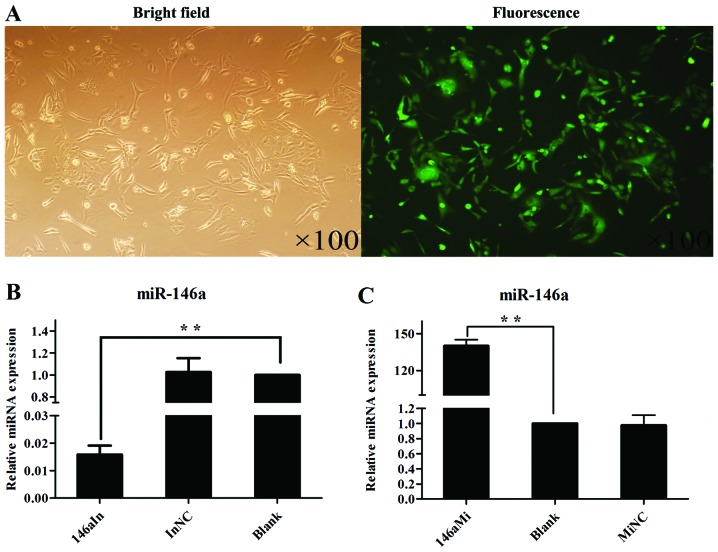
mMiR-146a oligonucleotide transfection and miR-146a expression in human chondrocytes. (B and C) Human chondrocytes were transfected with miR-146a mimics (146aMi), negative control mimics (MiNC), miR-146a inhibitors (146aIn), negative control inhibitors (InNC) and vacuous oligonucleotide (Blank). (A) Human chondrocytes were observed with white bright (left panel) and green fluorescence assay (right panel) in the same vision using a fluorescence microscope (magnification, ×100) at 24 h after transfection. (B) miR-146a expression levels were evaluated by RT-qPCR in the chondrocytes transfected with miR-146a inhibitors (146aIn) and negative control inhibitors (InNC) (**P<0.01; bars, means ± SD; n=3). (C) miR-146a expression levels were evaluated by RT-qPCR analysis in chondrocytes transfected with miR-146a mimics (146aMi) and negative control mimics (MiNC) (**P<0.01; bars, means ± SD; n=3).